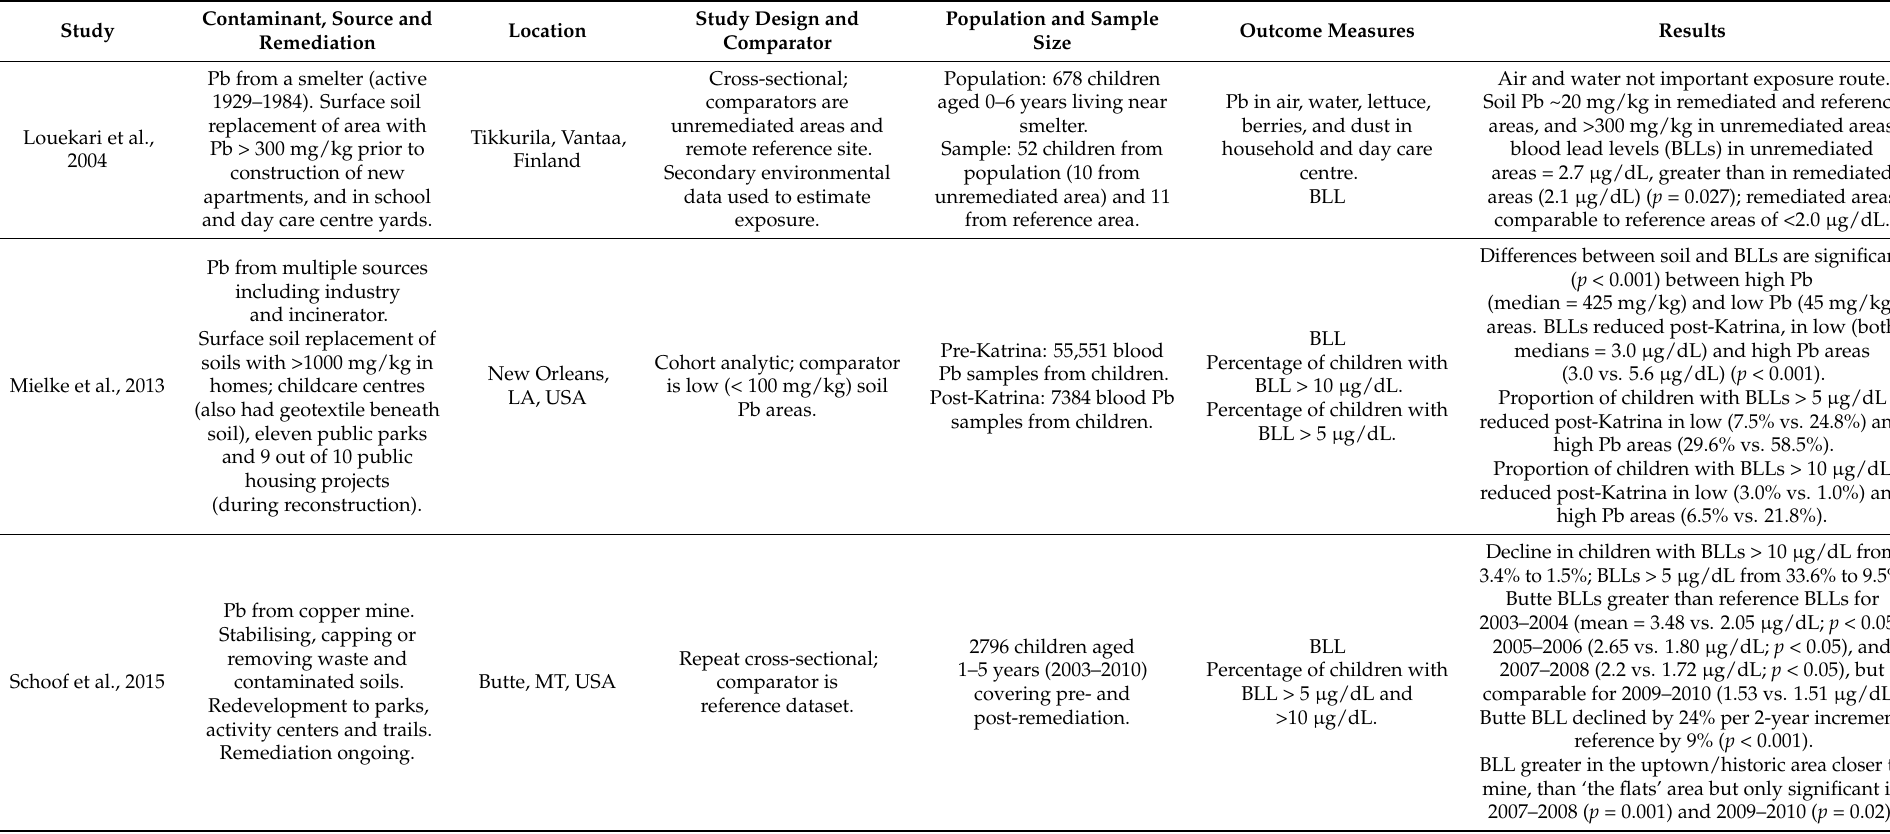
Table 3. Studies reporting health-related outcomes for people living near remediated sites following remediation and